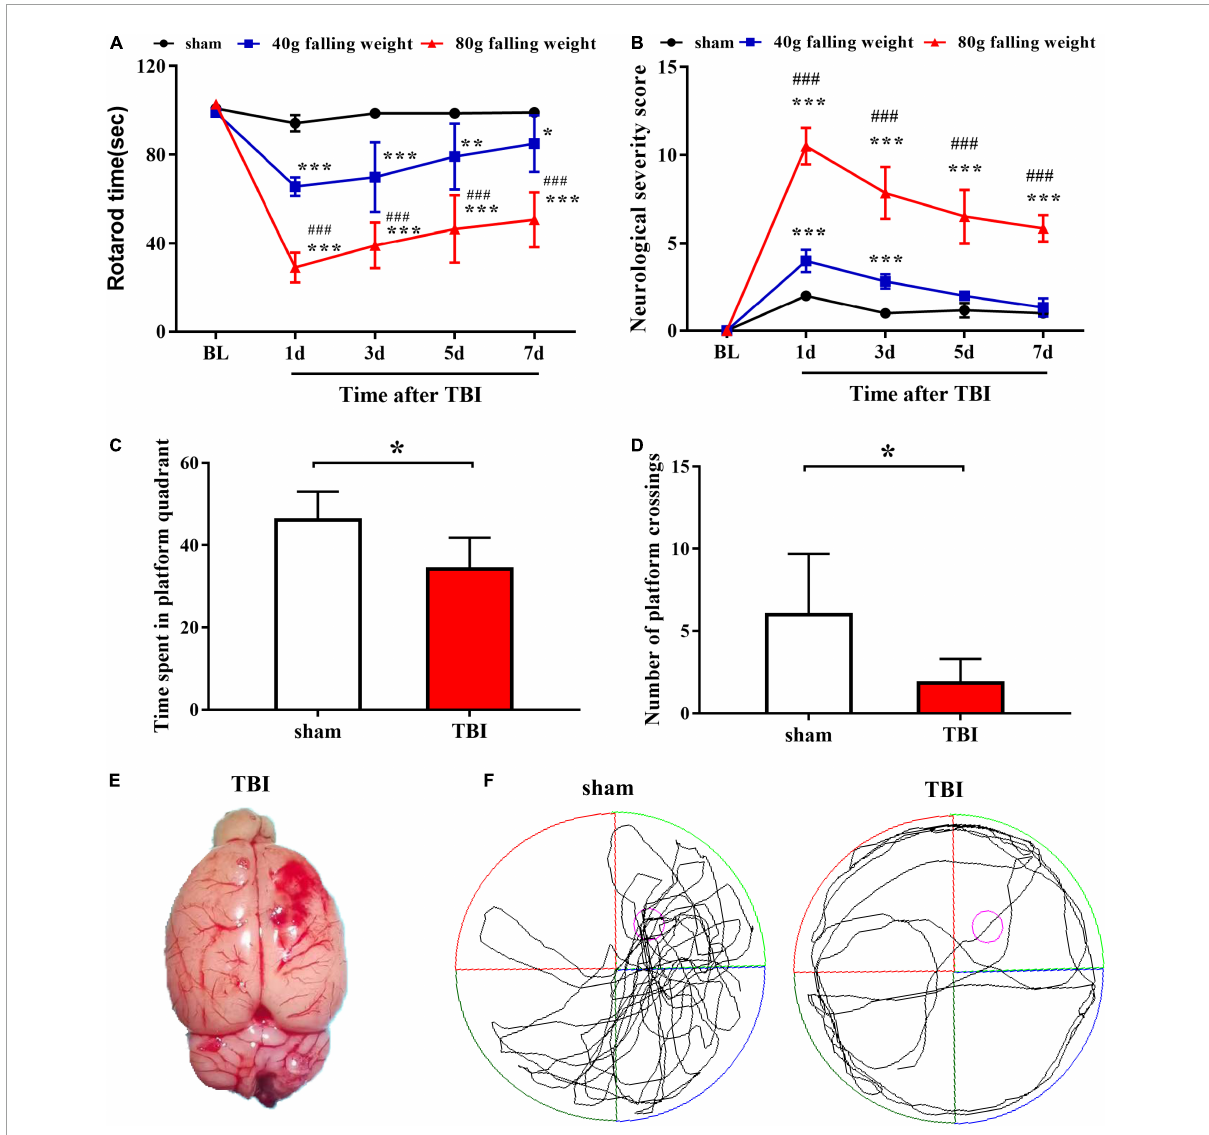
FIGURE1 Traumatic brain injury caused significant motor dysfunction and nerve function damage, as tested by the rotarod assay, neurological severity score scale and Morris water maze test. Behavior was evaluated at multiple time points by the rotarod test (A) and neurological severity score (B) , which indicated persistent damage to motor function in TBI ( n = 6 rats per group. Two-way ANOVA with repeated measures followed by Tukey’s multiple comparisons test. * p < 0.05, ** p < 0.01, *** p < 0.001, sham vs. 40 g falling weight; ### p < 0.001, 80 g falling weight vs. 40 g falling weight. The values are expressed as the means ± SD. Baseline, BL). The time spent in the platform quadrant (C) and the number of platform crossings (D) were recorded to assess the cognitive function of rats ( n = 6 rats per group. Student’s unpaired t -test, * p < 0.05. TBI vs. sham. The values are expressed as the means ± SD). (E) Photograph of a rat brain showing a typical lesion from TBI over the right frontal lobe. (F) The swim paths shown for sham and TBI groups were those of a single animal in the probe test. The hidden platform was indicated by the purple